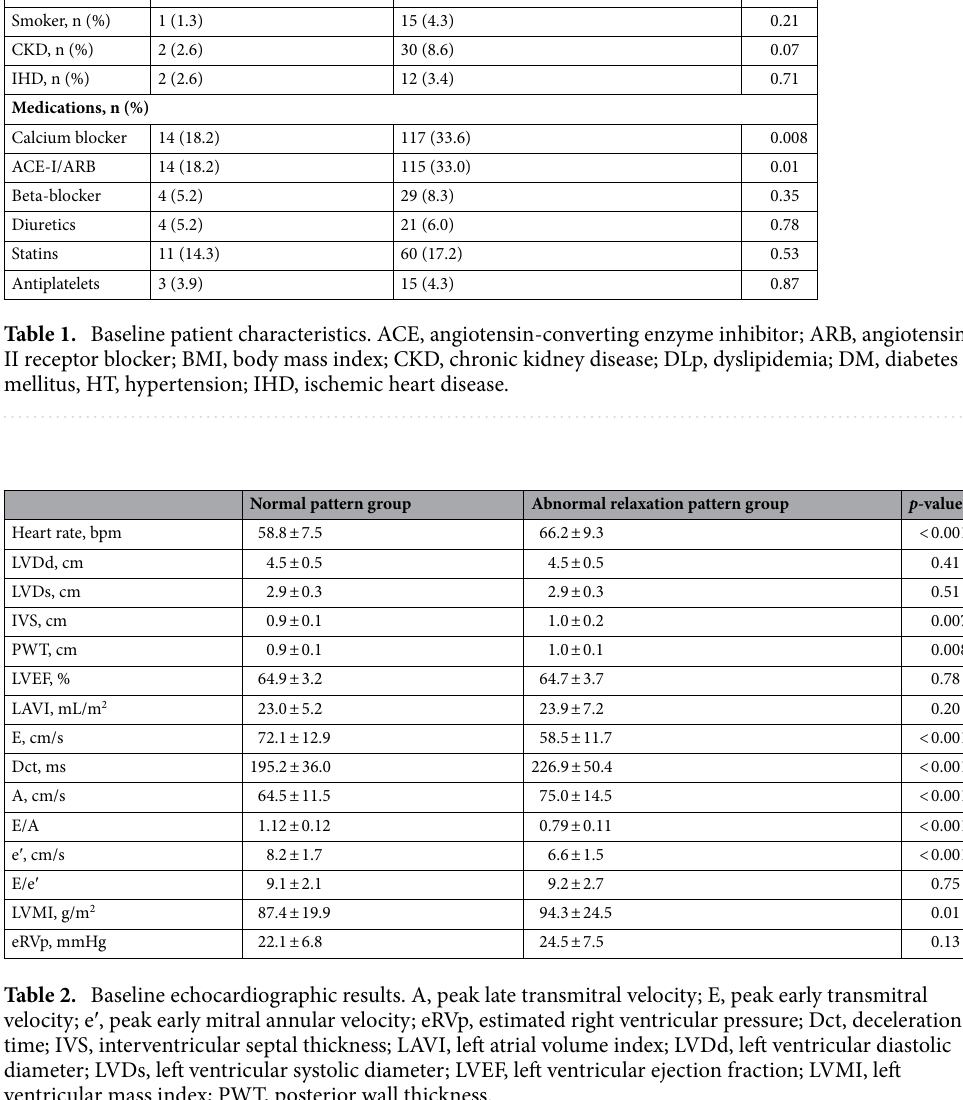
Table 2. Baseline echocardiographic results. A, peak late transmitral velocity; E, peak early transmitral velocity; e ′ , peak early mitral annular velocity; eRVp, estimated right ventricular pressure; Dct, deceleration time; IVS, interventricular septal thickness; LAVI, left atrial volume index; LVDd, left ventricular diastolic diameter; LVDs, left ventricular systolic diameter; LVEF, left ventricular ejection fraction; LVMI, left ventricular mass index; PWT, posterior wall thickness.